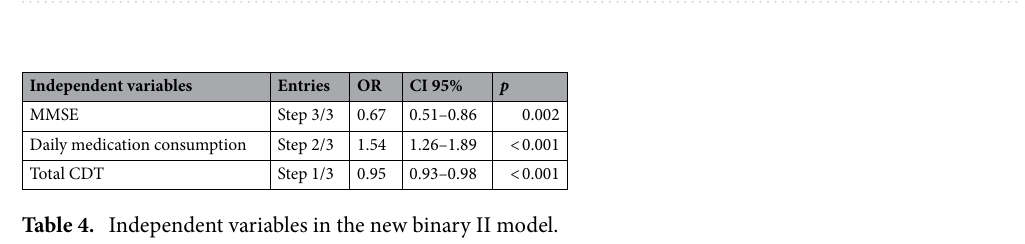
Table 4. Independent variables in the new binary II